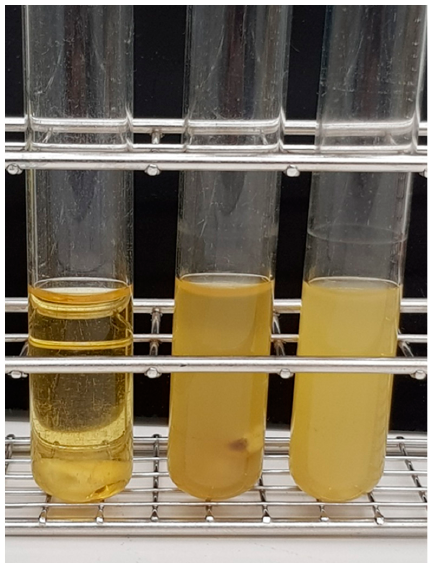
Figure 1. Colonization of tooth specimen. Teeth were placed in test tubes containing Brain Heart Infusion (BHI) medium inoculated with either B. subtilis or S. epidermidis and incubated for at least three days at 30 °C to allow for colonization and biofilm development. From left to right: inoculated test tube before incubation, B. subtilis and S. epidermidis culture after one day of bacterial growth. For disinfection experiments, the teeth were removed from the test tubes and the outer surfaces were carefully sterilized while using a mixture of 32.5% isopropanol, 18% ethanol, 0.1% glutaraldehyde, and 49.4% distilled water, which is highly bactericidal [29] and routinely used for tooth sterilization by us (unpublished). The success of treatment was controlled by pressing the outer tooth surfaces on BHI agar plates, which were subsequently incubated overnight at 30 °C. Following individual placement in 1.5 mL reaction tubes, phosphate-buffered saline (137 mM NaCl, 2.7 mM KCl, 10 mM Na 2 HPO 4 , 2 mM KH 2 PO 4 , pH 7.4) was added as an electrolyte until the teeth were